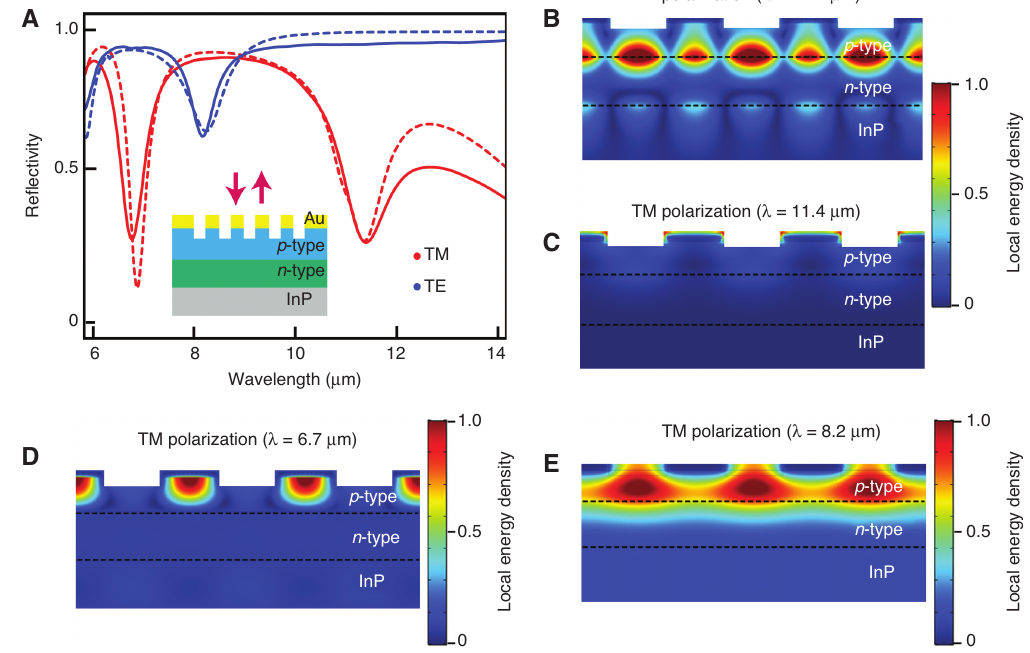
Figure 3: SPPD reflectivity spectra and local electromagnetic mode profiles. (A) Transverse magnetic (TM) and transverse electric (TE) polarized reflectivity spectra of the In under zero bias. The experimental data (solid lines) is compared with self-consistent electro-optic simulations (dashed lines). The local electromagnetic energy densities across the device for the two incident light polarizations: (B–D) Transverse magnetic (TM) and (C, E) transverse electric (TE). The electromagnetic mode profiles unambiguously shows the excitation of SPP at the pn ++ junction interface for incident TM radiation with free-space wavelength of λ = 11.4 μ